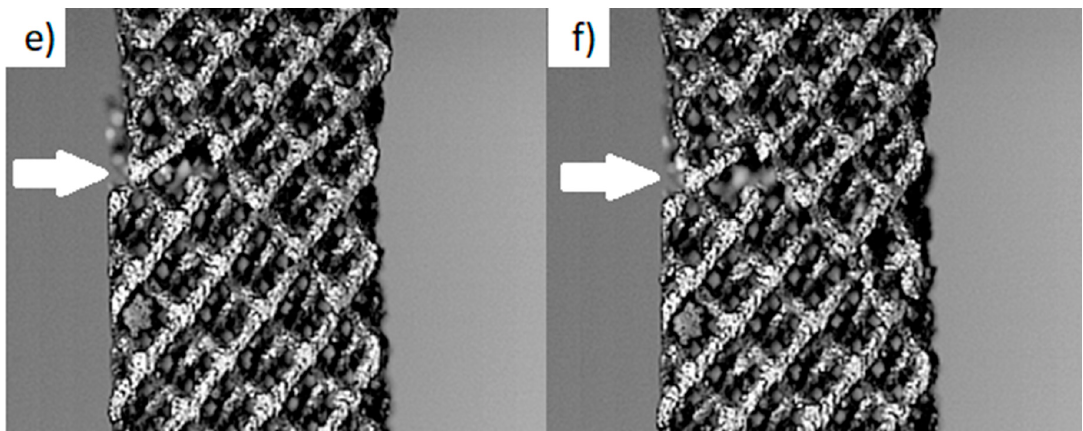
Figure 6. Crack initiation and propagation up to destruction in an expanded Ti6Al4V titanium alloy sample with a porosity of 81%: crack initiation at the first bar ( a ), cracking of the first bar ( b ), cracking of the next bars ( c – e ), rupture of the sample ( f ).